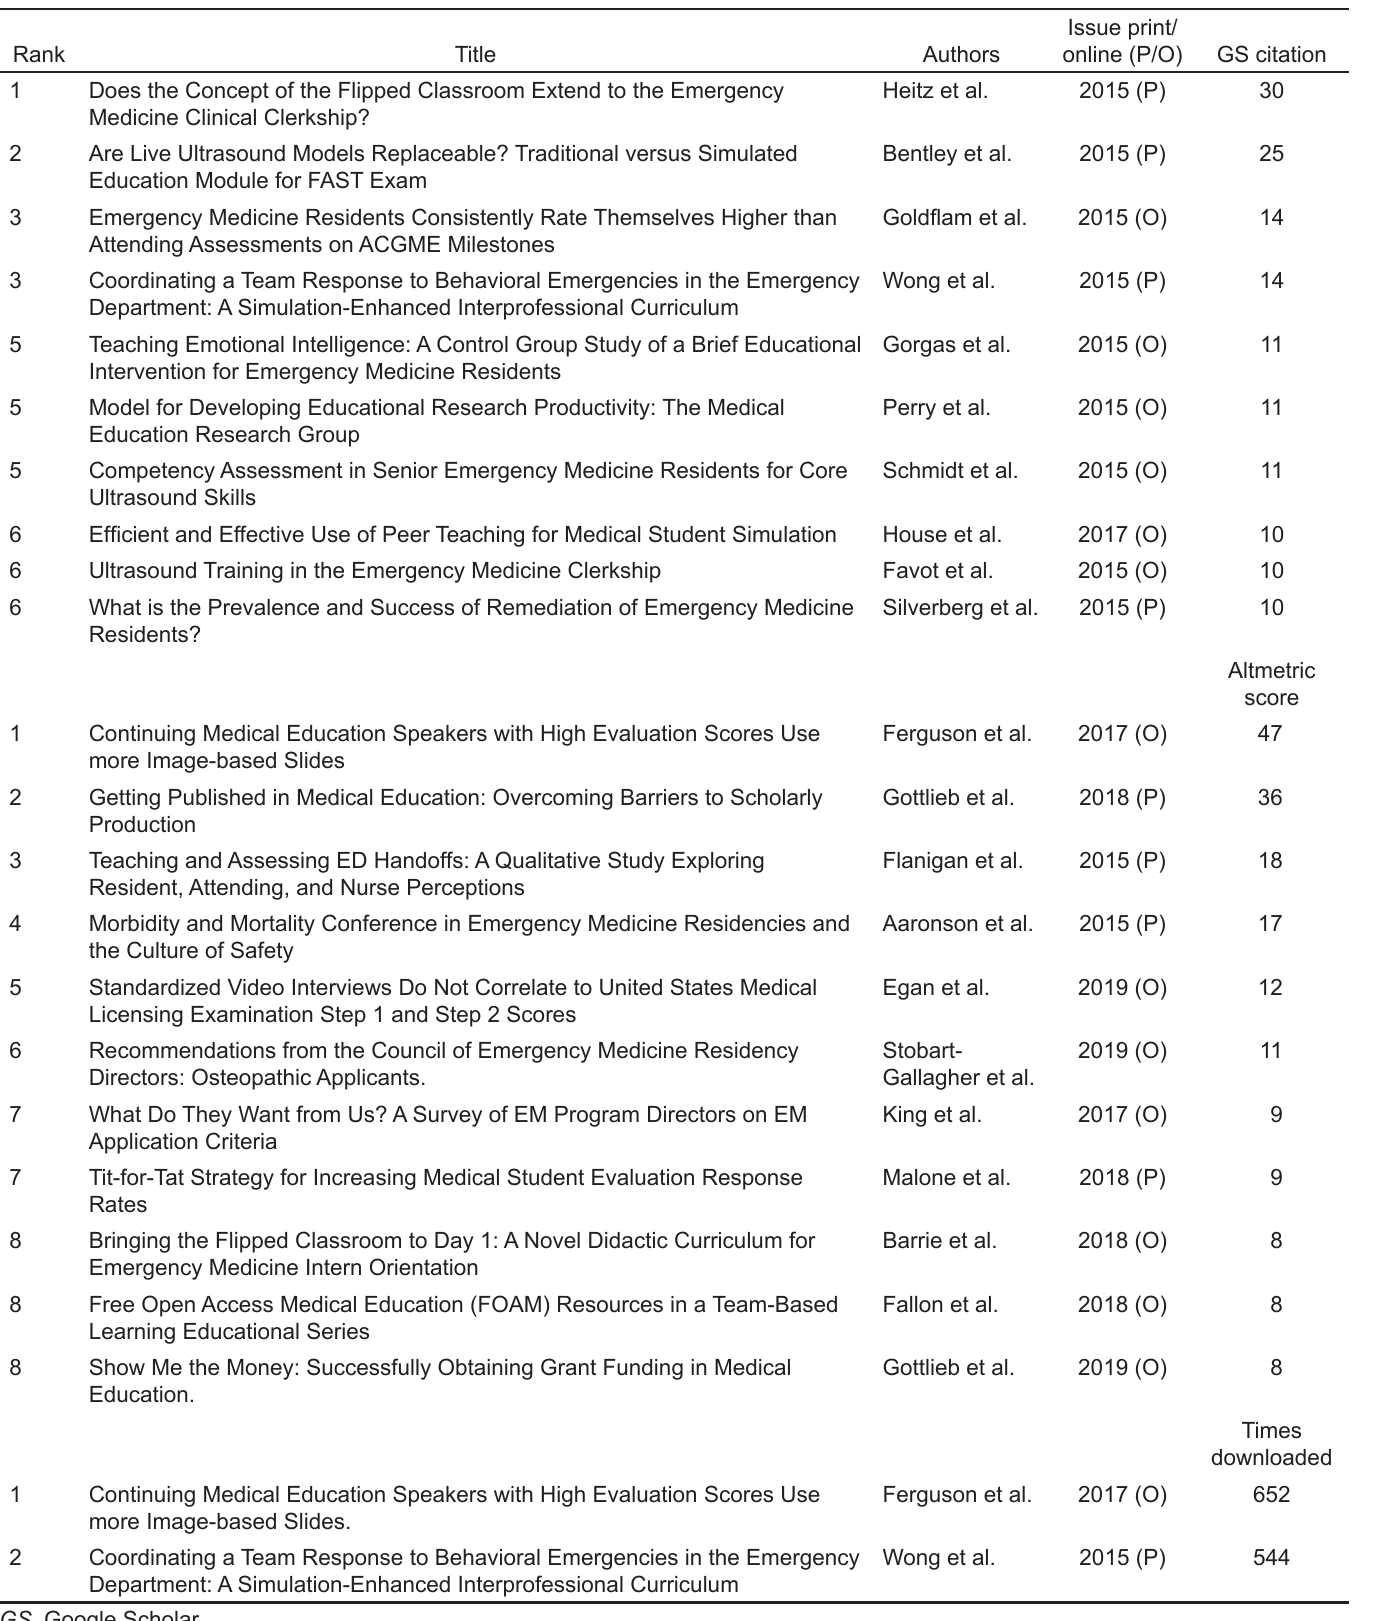
Table 1. Top 10 performing publications from the first four issues of the Western Journal of Emergency Medicine Special Issue in Educational Research and Practice (2015-2019) as determined by Google Scholar, Altmetrics, and